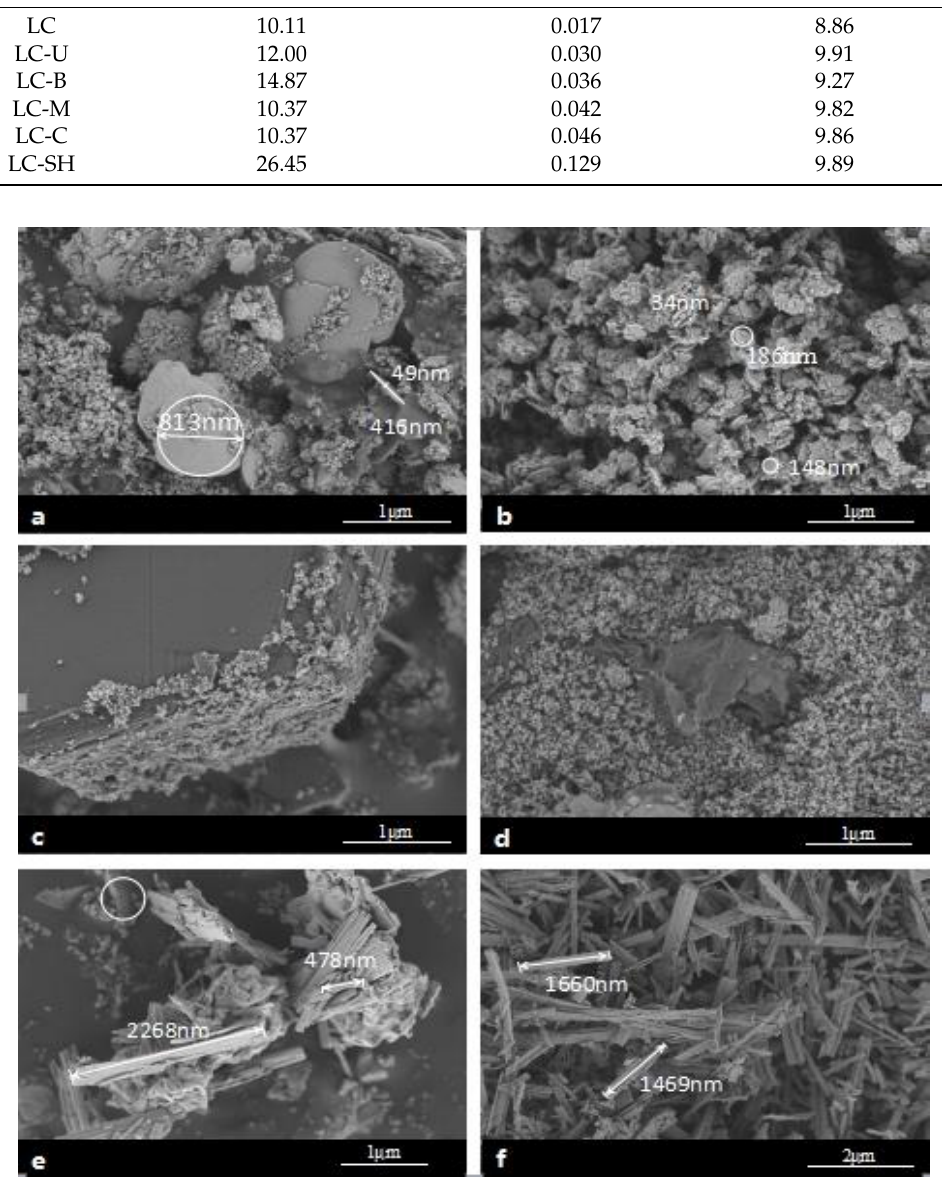
Figure 4. Scanning electron microscopy (SEM) photos of catalysts with different nitrogen sources. ( a ) LC-U; ( b ) LC-B; ( c ) LC-M; ( d ) LC-C; ( e ) and, ( f ) Table 1. Brunauer-Emmett-Teller (BET) results of catalysts with different nitrogen sources.